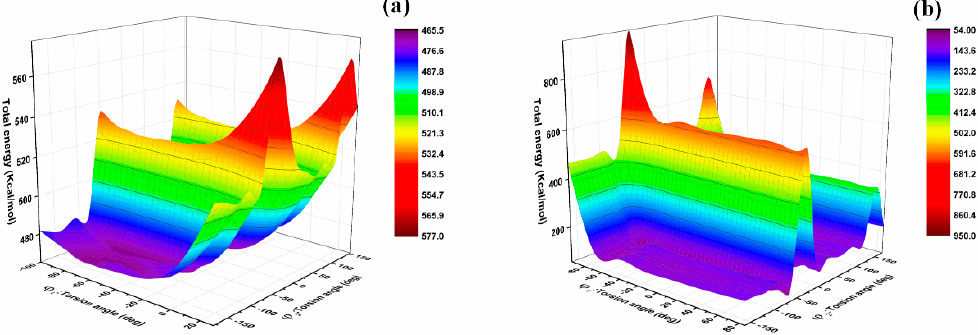
Figure 7. The potential energy graph of the bonds φ 1 and φ 2. ( a ) DGEBA-MTHPA; ( b ) DGEBA-NA.